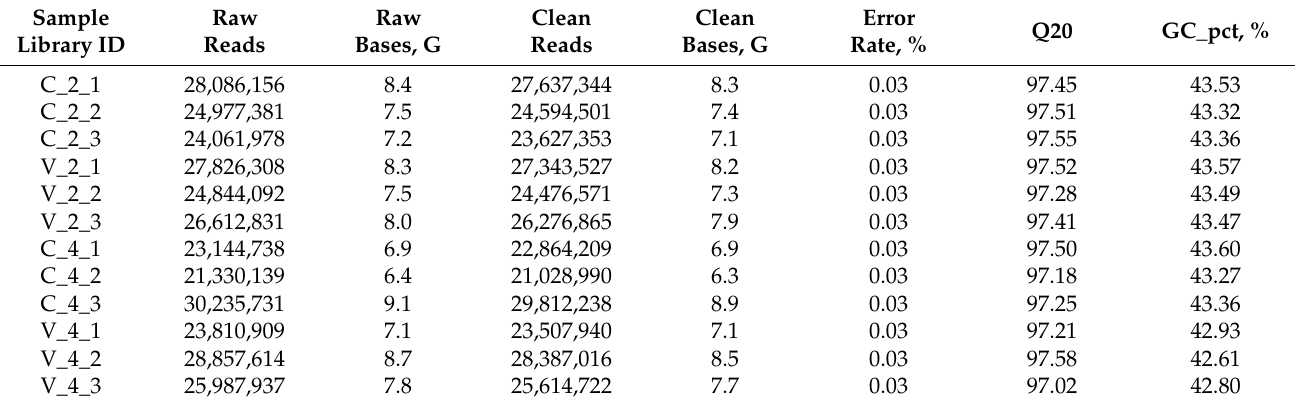
Table 1. Summary data of quality control (QC) of reads of the genome R. nigrum cv. Aldoniai.